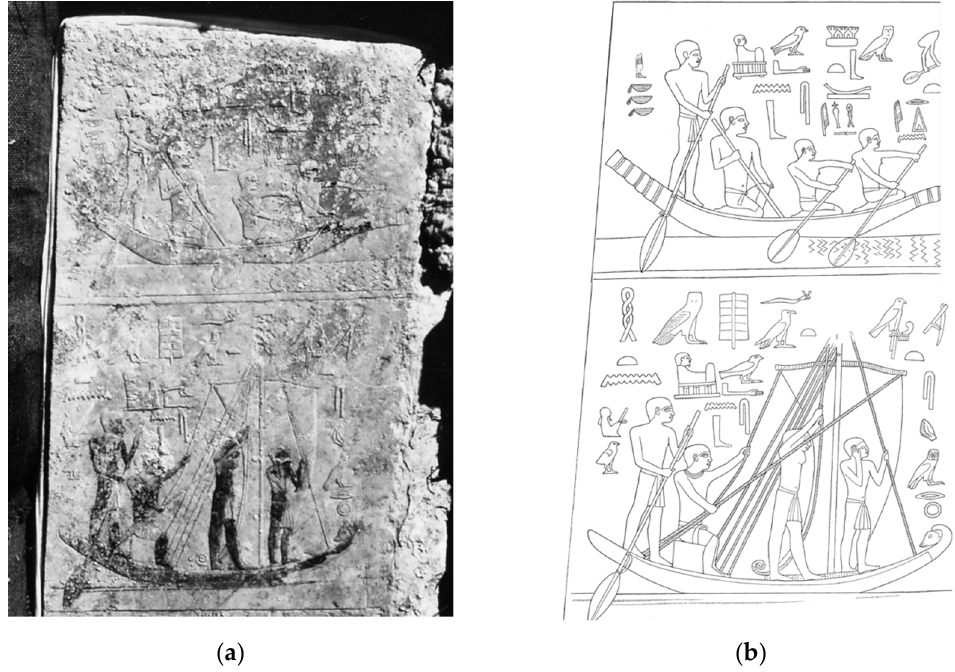
Figure 5. ( a ) South outer jamb of Seneb’s false door (Cairo JE 51297), with men sailing in hedgehog-head boat in the second register. Detail adapted from digital reproduction in the Digital Giza Archives (KHM_AEOS_II_3089) ( b ) Line drawing of south outer jamb of Seneb’s false-door. Adapted from Junker (1941, abb. 14a–b).